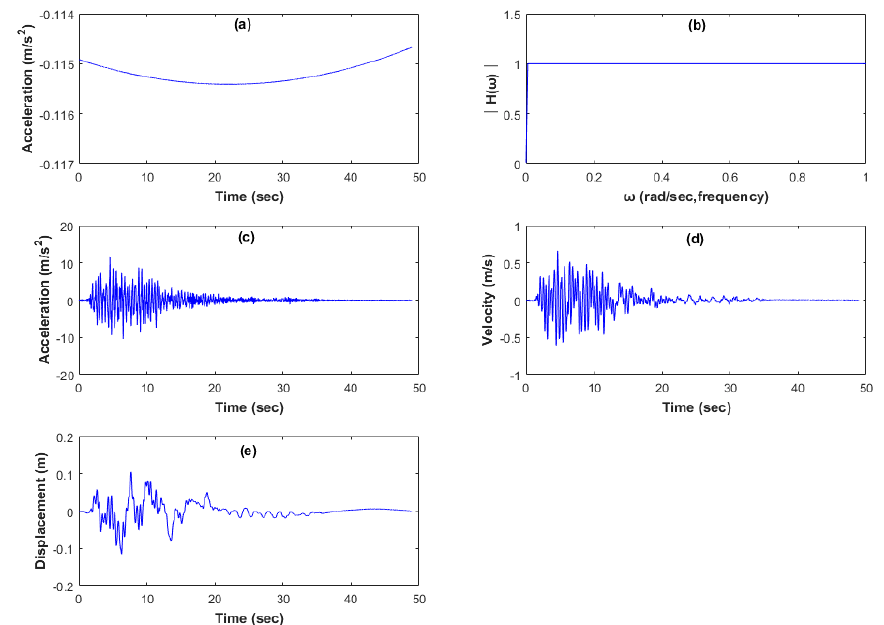
Figure 19. Analysis process for the 10th-story acceleration during the Superstition Hills earthquake using Method 3: ( a ) 2nd-order polynomial equation for correcting acceleration; ( b ) 4th-order Butterworth high-pass filter; ( c ) acceleration; ( d ) velocity; ( e ) displacement.